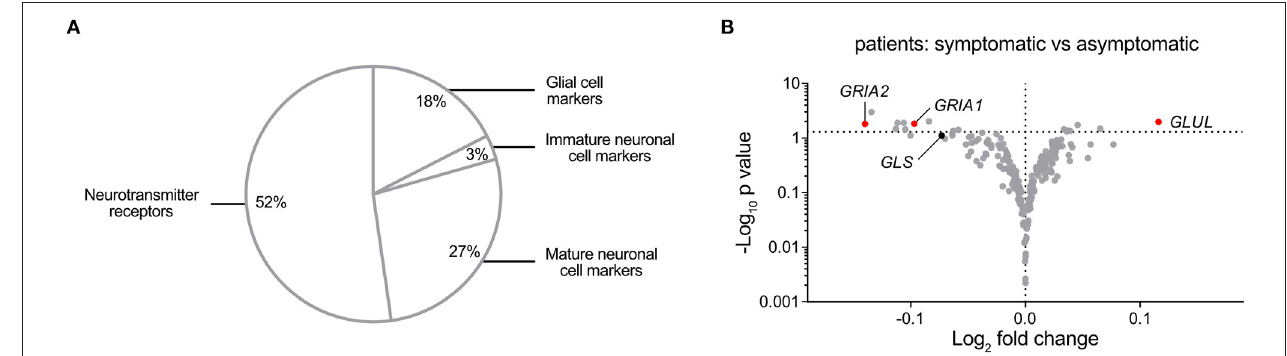
FIGURE 6 | A Comprehensive Analysis of nervous system-associated Transcripts in Carotid Atherosclerosis Segregates Glutaminase, Glutamate-Ammonia Ligase, and AMPA-type Receptors. (A) Pie chart showing classification of the compiled 217 neuronal-associated genes investigated by expression analysis in BiKE plaques. (B) Volcano plot visualization of differentially expressed genes between symptomatic ( n = 87) and asymptomatic ( n = 40) patient groups. Glutamate-related genes are shown in red when their expression is statistically significantly different between conditions, otherwise glutamate-related markers are represented in black. GRIA1 , Glutamate Ionotropic Receptor AMPA-type Subunit 1; GRIA2 , Glutamate Ionotropic Receptor AMPA-type Subunit 2; GLS , Glutaminase; GLUL , Glutamate-ammonia ligase. Fold change is expressed as “log 2 (mean expression level symptomatic/asymptomatic).” Differences between groups were analyzed using unpaired Student’s t